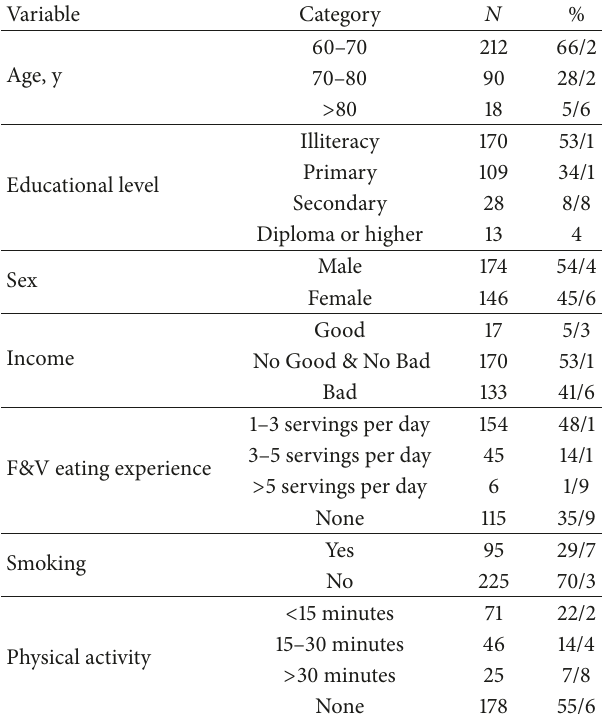
Table 1: Characteristics of